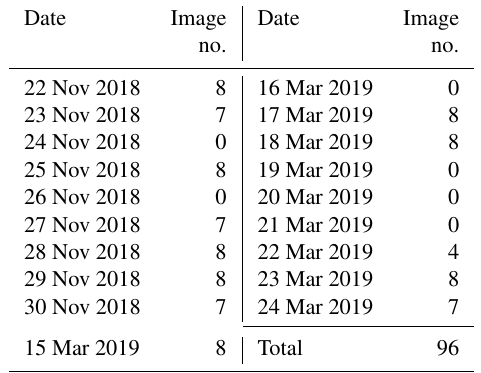
Table 2. The usage of GOCI images from November 2018 to March